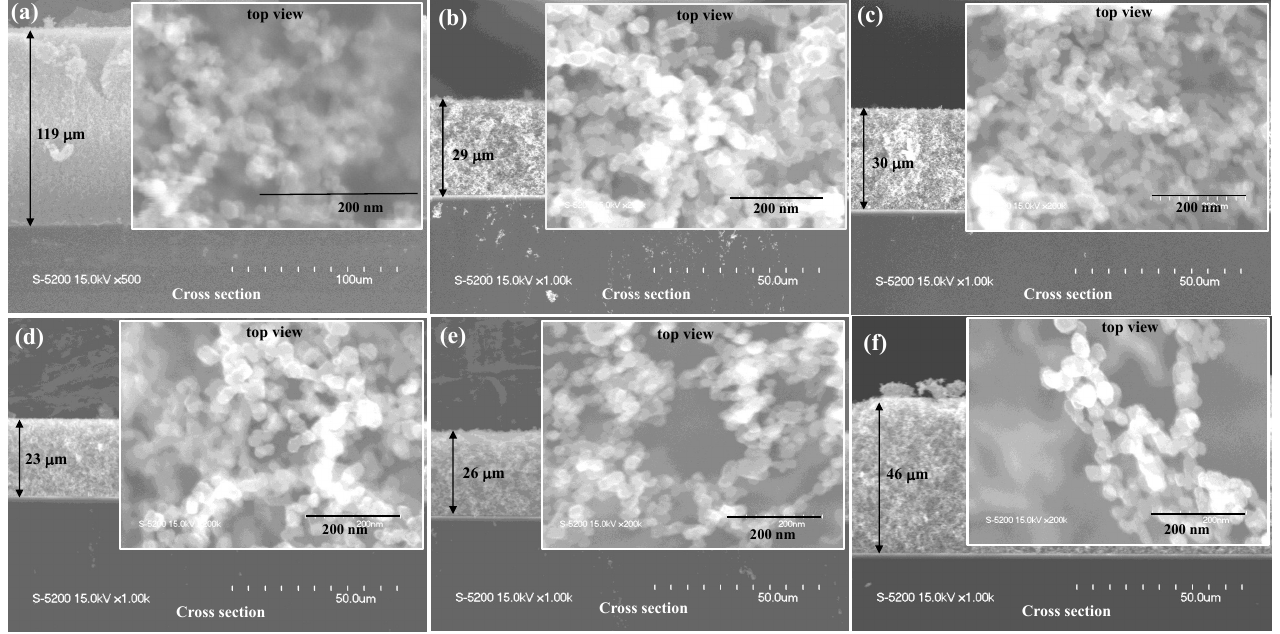
Figure 1. SEM images on the top views and cross section areas of nanocomposite thin films with a different heating rate: as-deposited film ( a ), 3 ◦ C/min ( b ), 5 ◦ C/min ( c ), 10 ◦ C/min ( d ), 30 ◦ C/min ( e ), and 60 ◦ C/min ( f ). Annealing temperature was kept constant at 600 ◦